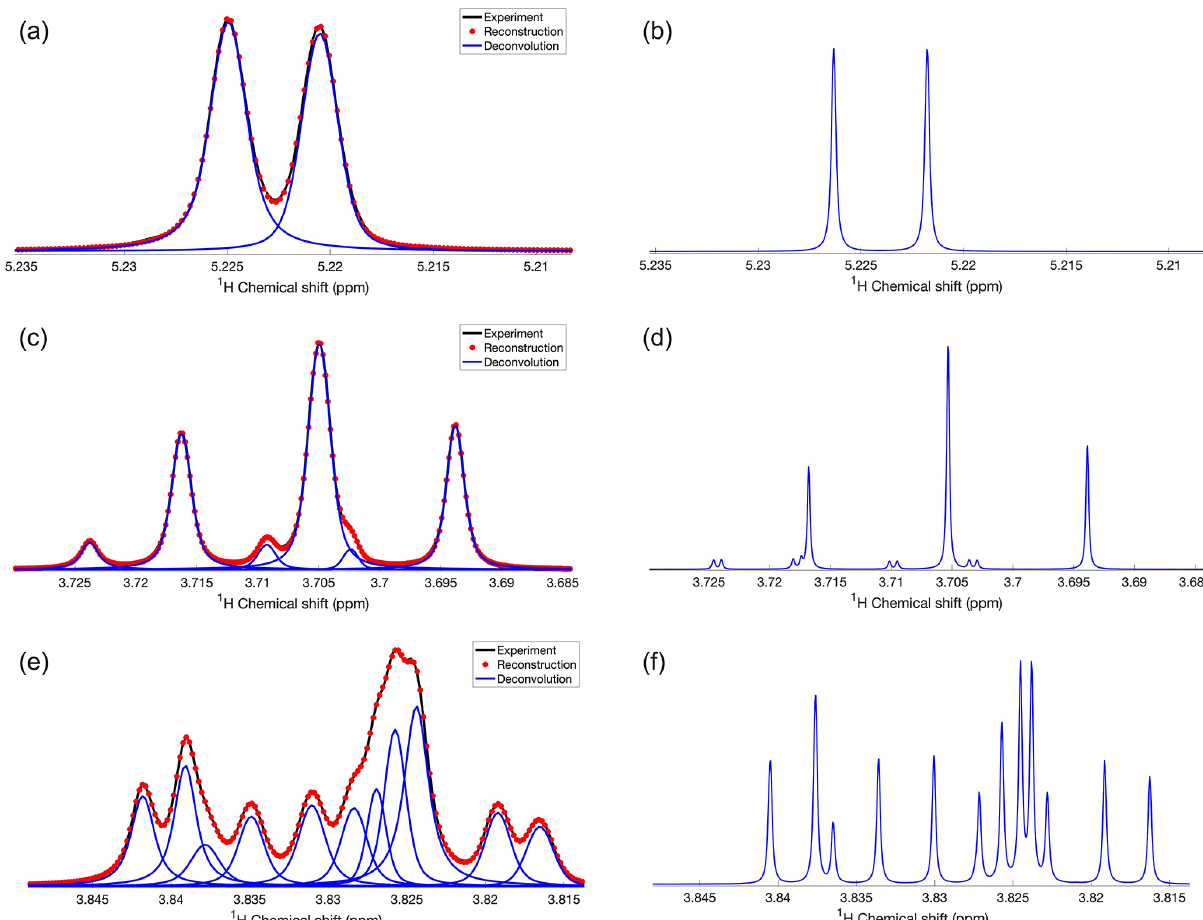
Figure 1. Demonstration of DEEP Picker1D and Voigt Fitter1D for selected regions of a 1D 1 H spectrum of glucose. ( a , c , and e ) Exper- imental and reconstructed spectra are depicted in black lines and red dots, respectively. Deconvoluted individual peaks are depicted as blue lines. ( b , d , and f ) Simulated spectra including strong coupling effects with the spin Hamiltonian constructed based on parameters taken from the GISSMO website at the same B 0 field strength (850MHz 1 H frequency) as in the experiments. Transverse R 2 relaxation rates were uniformly set to a low value of 0.6s − 1 to obtain a very high-resolution spectrum for better comparison with DEEP Picker. Pairs of panels (a, b) , (c, d) , and (e, f) show the same 1D spectral regions. DEEP Picker1D and Voigt Fitter1D correctly deconvoluted the experimental spectra for the simple region (a) and more complex regions (c, e) . A few peaks cannot be deconvoluted because of strong spectral overlap, such as the small peak around 3.717ppm in (d) and the peak around 3.823ppm in (f) . The deconvolution by DEEP Picker1D was performed with model 2 with a PPP number of